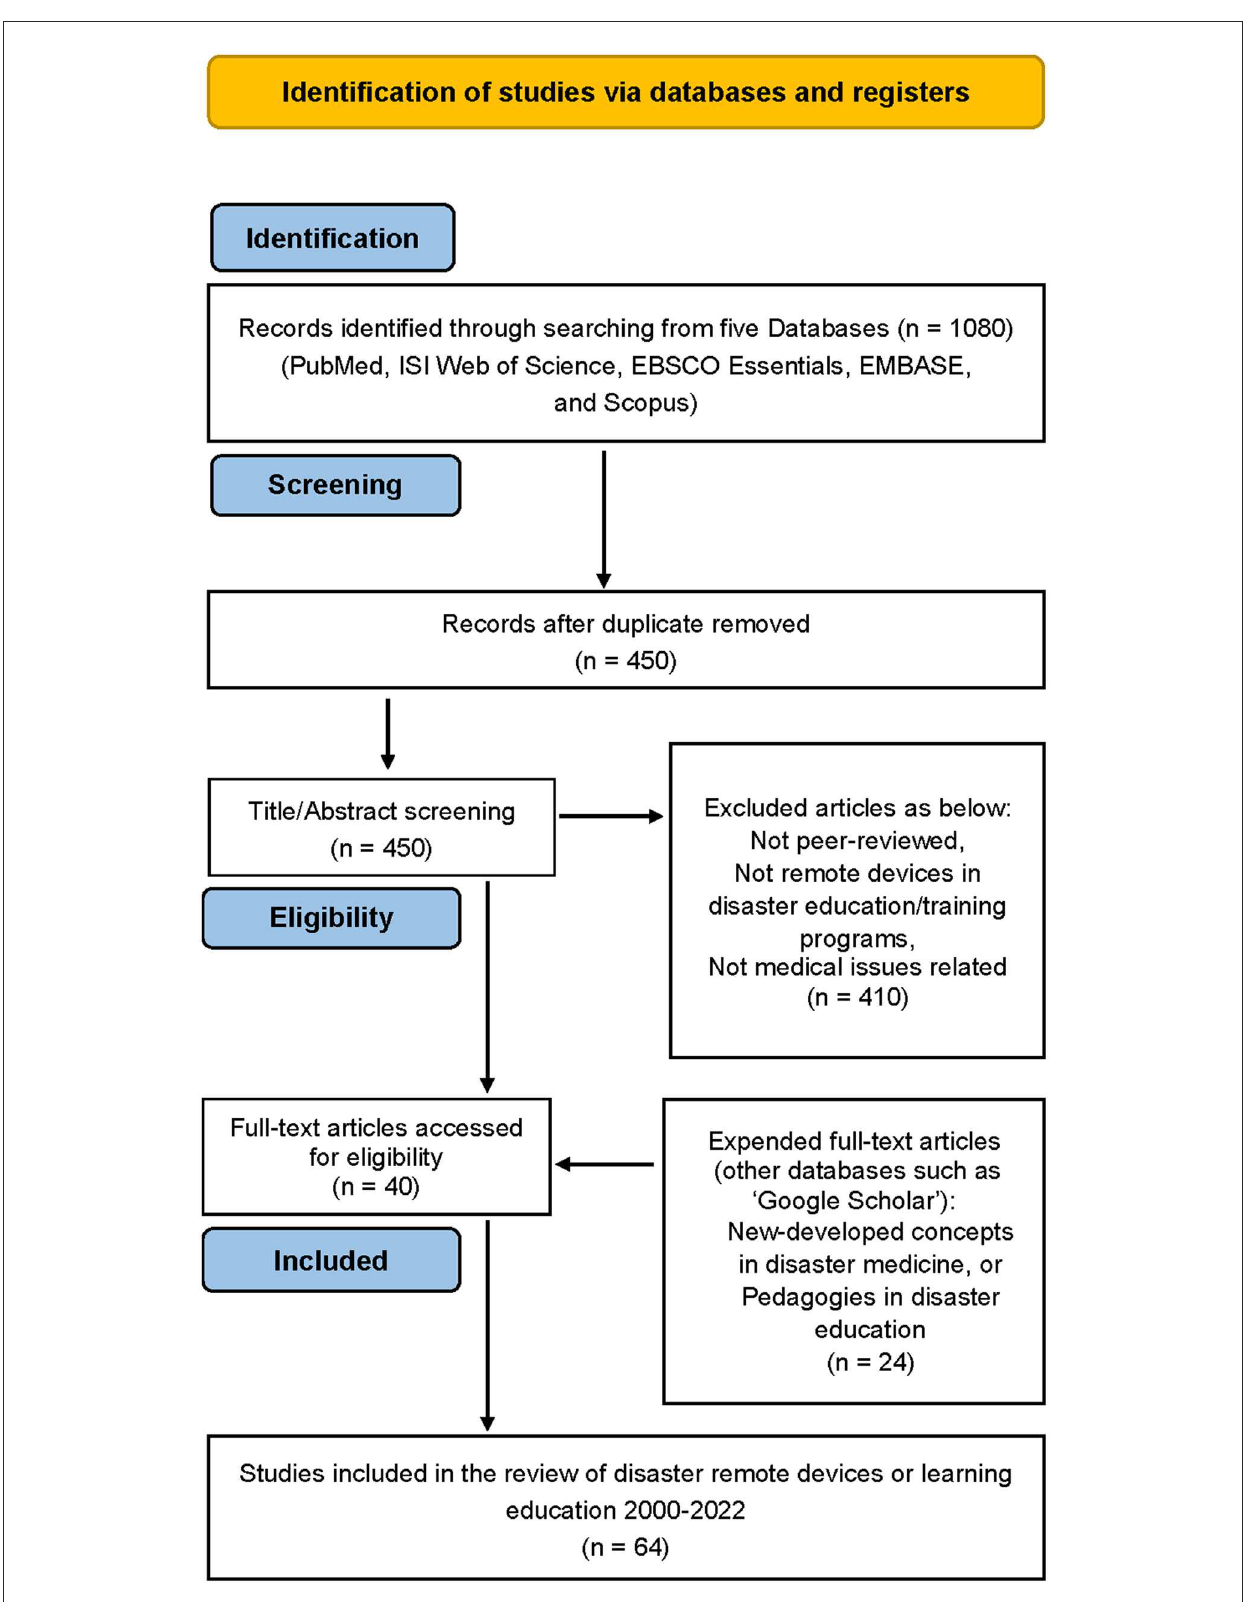
FIGURE1 Flow of the literature search process (PRISMA